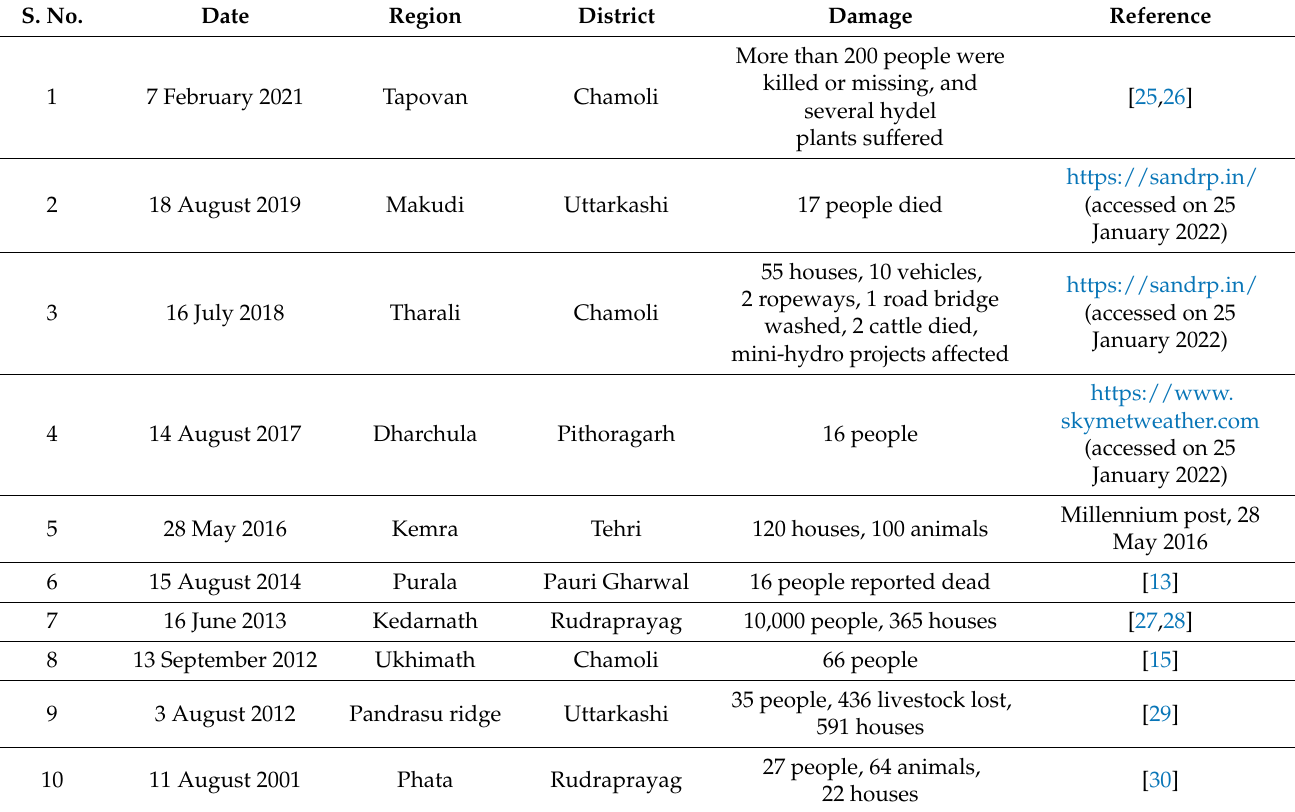
Table 3. The list of major flash-flood locations in the state of